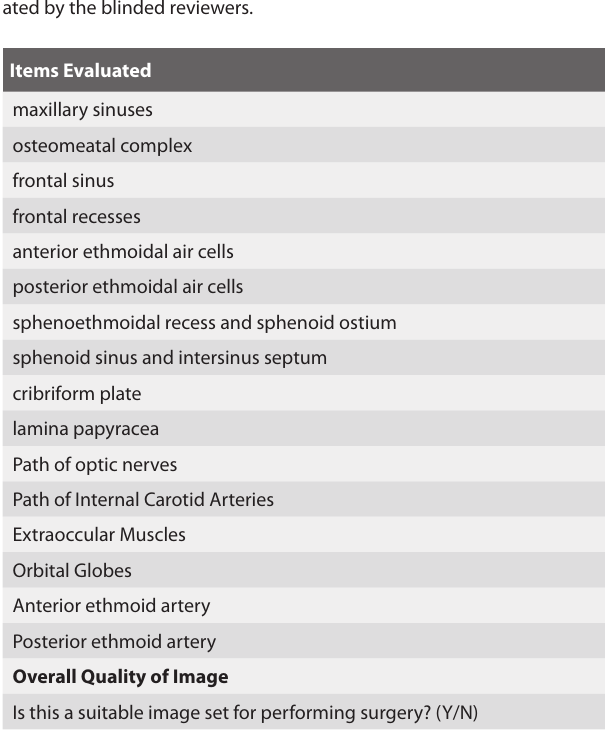
Table 2. Anatomical features and other characteristics that were evalu- ated by the blinded